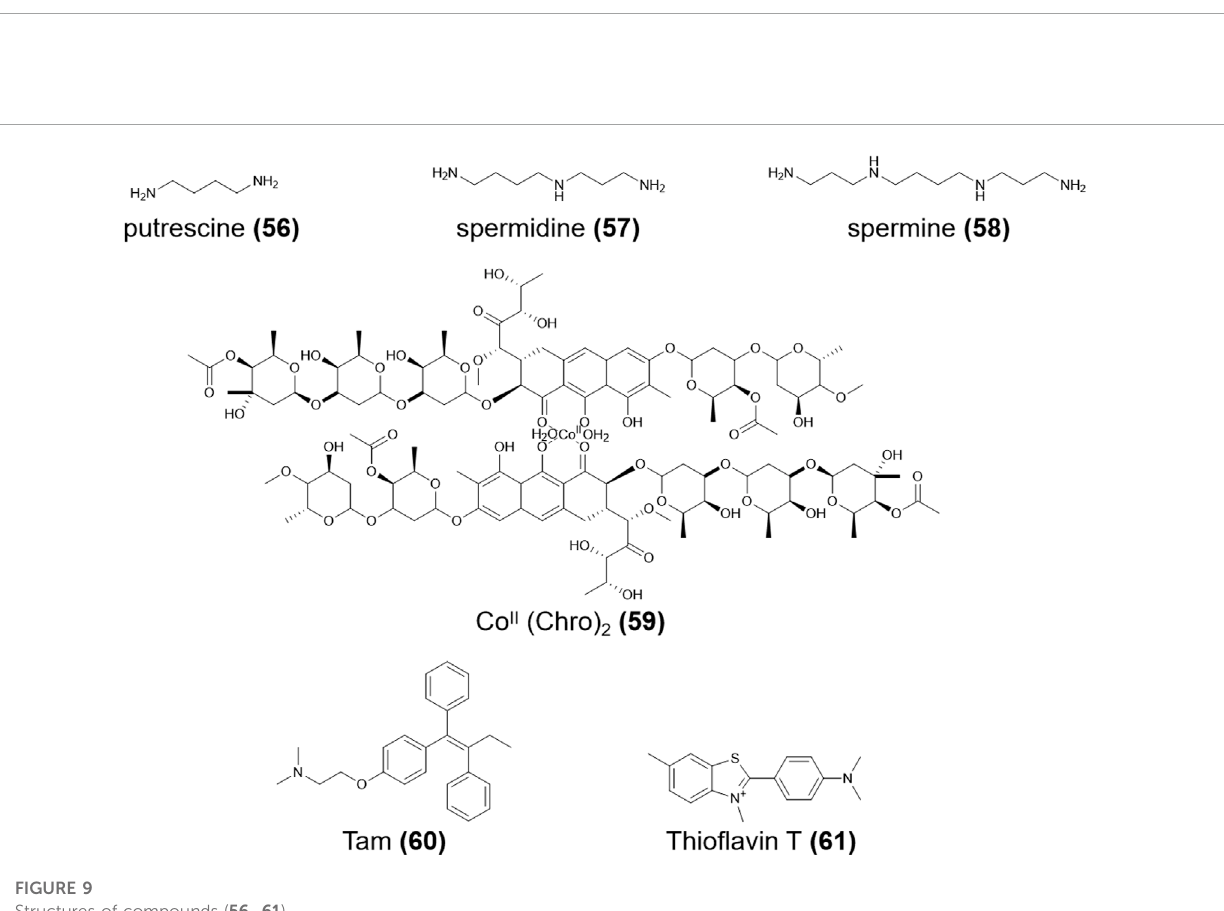
FIGURE 8 Mechanism of i-motifs in vivo . The i-motif DNA sequence folds into i-motif structures in speci fi c conditions, including acid pH, K + , or some small molecules. I-motifs mainly have two effects: fi rstly, they directly bind to proteins such as hnRNP A1, hnRNP K, and hnRNP LL; second, they can directly interact with ligands. The result is switching gene expression on or off. Activated genes produce corresponding proteins after transcription. These proteins interact with other factors and form complexes that are transported to certain tissue. The release of these proteins can lead to tumors, neuropathy, aging, HIV, and autoimmune disease.